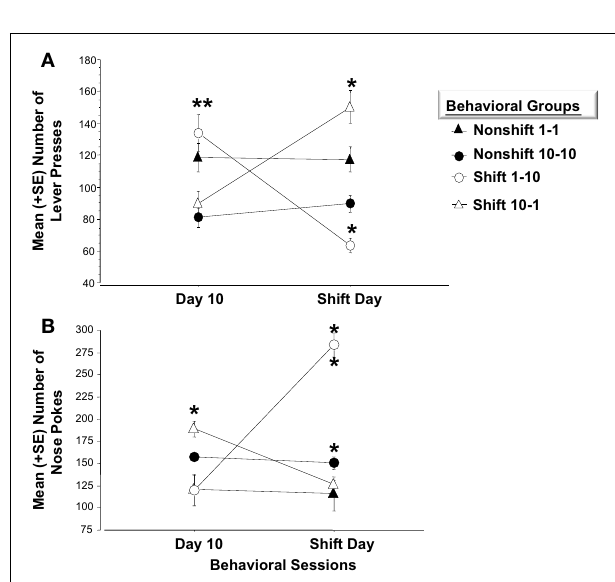
FIGURE 6 | (A) Mean ( + SE) number of lever presses on the final day of initial training and in response to the unexpected change in reward magnitude on the Shift Day . On Day 10, animals accustomed to only (1) sucrose pellet following each FR-5 schedule (i.e., open circle and closed triangle ), make significantly more lever presses than those given (10) sucrose pellets for each FR-5 during the first 10 days of training, ( ∗∗ p < 0 . 01). Animals assigned to either of the Nonshift groups (i.e., closed triangle and circle ) did not alter lever pressing behavior on the Shift day. A decrease in reward quantity (i.e., Shift 10-1 ; open triangle ) caused a significant increase in lever press responses relative to the number recorded on Day 10 ( ∗∗ p < 0 . 01) before the decrease in reward magnitude. Subjects in the Down-shift group displayed a significantly higher level of lever presses on the Shift day compared to animals that received (1) sucrose reward throughout the experiment ( ∗∗ p < 0 . 01; open triangle vs. closed triangle ). Conversely, animals that experienced the Up-shift in reward from (1) to (10) sucrose pellets (i.e., open circle ) decreased